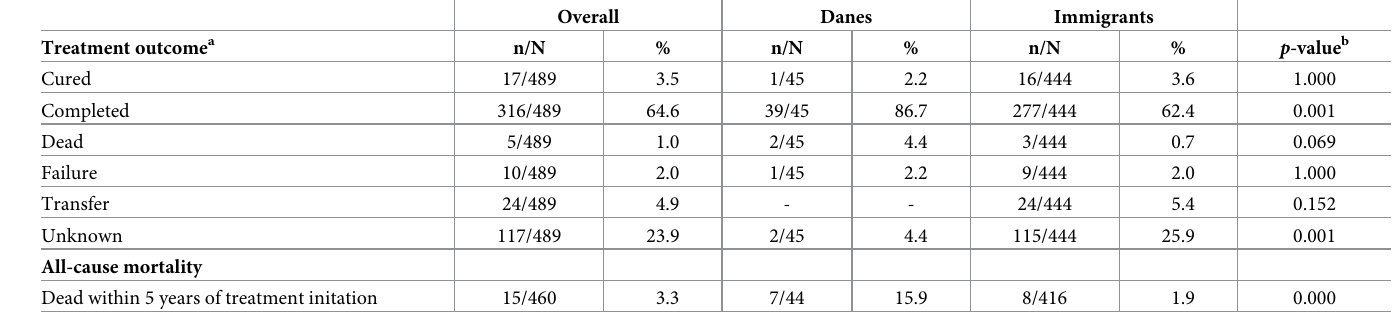
Table 2. Treatment outcome. Treatment outcome and all-cause mortality data for patients with tuberculous lymphadenitis in Denmark from 2007 through 2016.